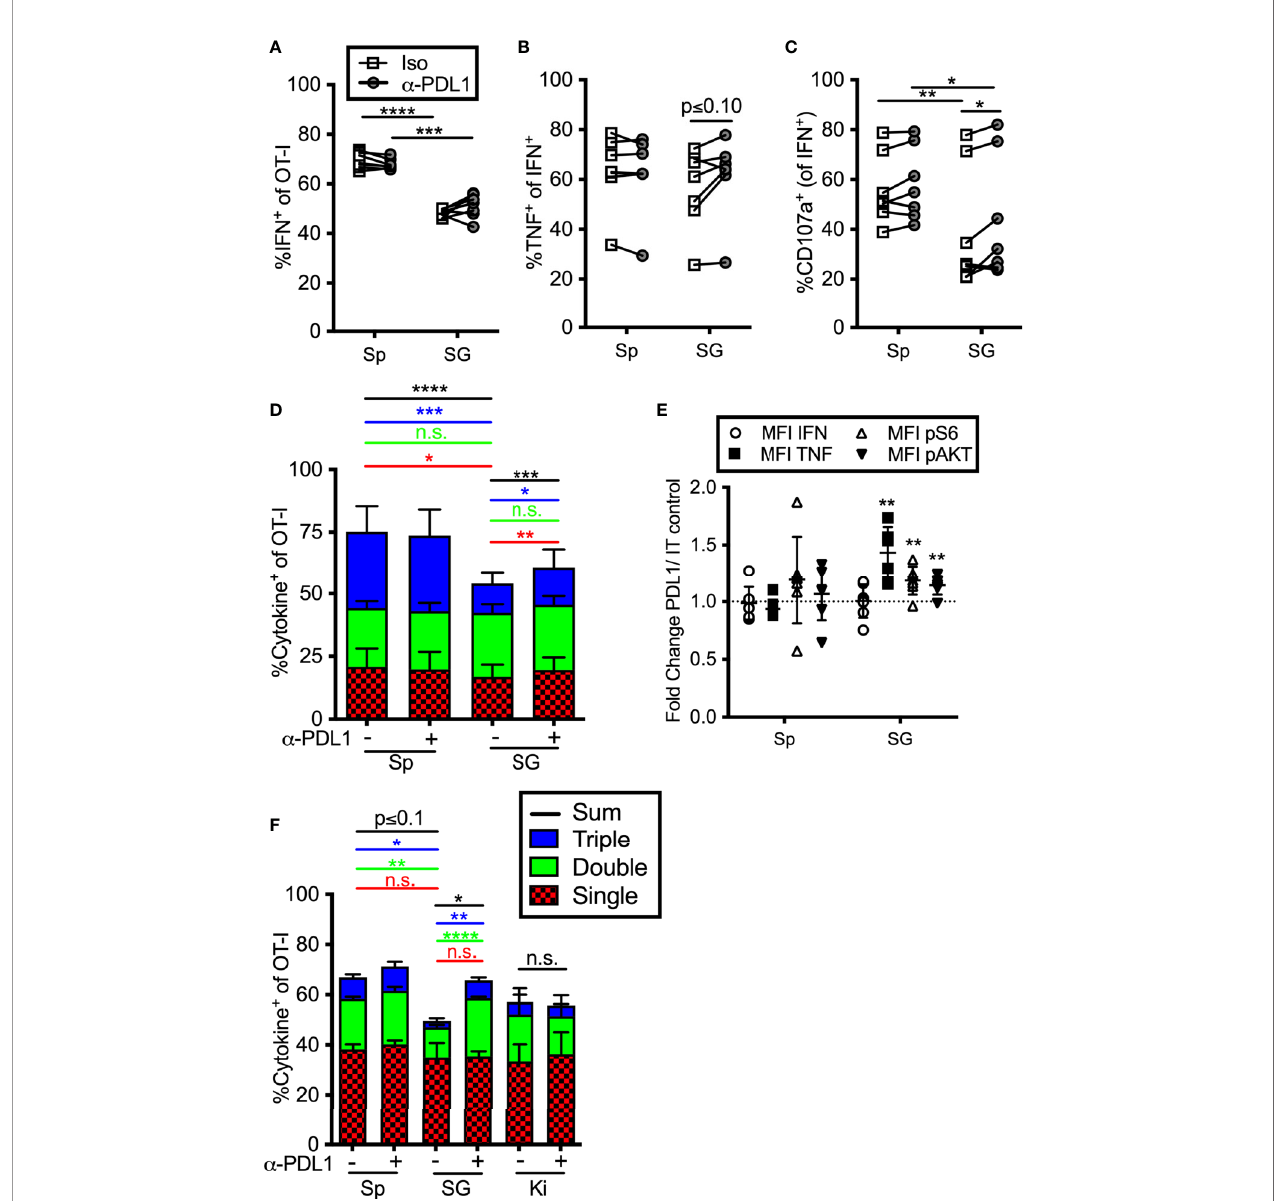
FIGURE 4 | Impact of blocking PD-L1 on T cell function ex vivo . (A – E) Mice were seeded with OT-Is and infected with MCMV-OVA. At least 3 months post infection OT-Is were harvested from the indicated organs as described in the materials and methods, and stimulated for 5 hours with SIINFEKL pulsed DC2.4s, in the presence of anti-PD-L1 or isotype control antibody (iso). (A) Frequency of OT-Is that produced IFN- g , or (B) co-produced IFN- g and TNF- a or (C) produced IFN- g and exposed CD107a during stimulation. Each line connects OT-Is from the same mouse (n=7 mice pooled from 3 independent experiments). Data were analyzed in pairwise fashion using paired, two-tailed t-tests to assess differences between cells recovered from different organs of the same mouse, or cells recovered from a single organ and restimulated with or without blocking antibody. (D) Boolean gating of OT-Is from (A – C) expressing IFN- g , TNF- a and/or CD107a after stimulation, (n=7 from 3 independent experiments). Populations expressing 1, 2, and/or 3 functions were analyzed by paired two-tailed t-tests. (E) Fold change in mean fl uorescence intensity of the indicated marker of anti-PD-L1 treated OT-Is relative to isotype control treated samples from samples in (A – D) . In order to compare the MFI of the indicated molecule across experiments, the data was plotted as the ratio between cells treated with the PD-L1 blocking antibody vs cells treated with the isotype control antibody. Therefore, a value of 1 would indicate no change between treated and control wells. Statistical tests were conducted using one sample t- tests between each condition and a hypothetical value of 1 (n=7 mice from 3 independent experiments). (F) Mice were seeded with OT-Is and infected with MCMV- OVA. At least 3 months after infection, mice were treated with anti-PD-L1 blocking antibody or isotype control antibody for 2 weeks. Lymphocytes were isolated from the indicated organs and stimulated for 5 hours with SIINFEKL pulsed DC2.4s in the presence of the same antibody that was injected into the mice. The data show Boolean gating of IFN- g , TNF- a and CD107a expression by OT-Is after stimulation. Since cells were derived from different mice treated with isotype control antibody or PD-L1 blocking antibody, populations expressing 1, 2, and/or 3 functions were analyzed by unpaired two-tailed t-tests. Data are from n=3 mice, representative of 2 independent experiments, n=6. *p ≤ 0.05, **p ≤ 0.01, ***p ≤ 0.001, ****p ≤ 0.0001, n.s., not signi fi